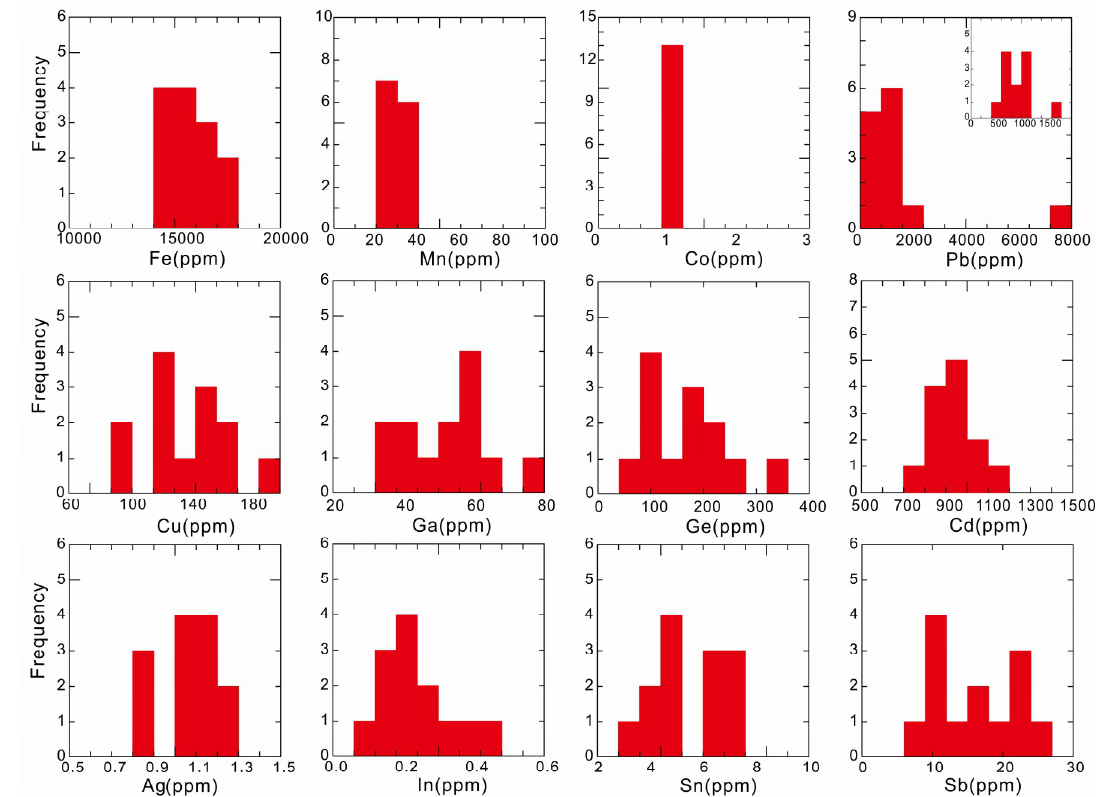
Figure 7. Histogram of trace elements in sphalerite of the Nayongzhi deposit.